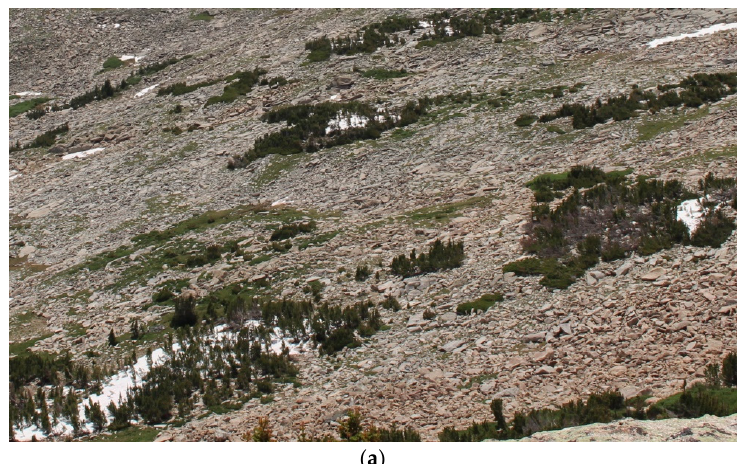
Figure 6. Cont. Figure 6.